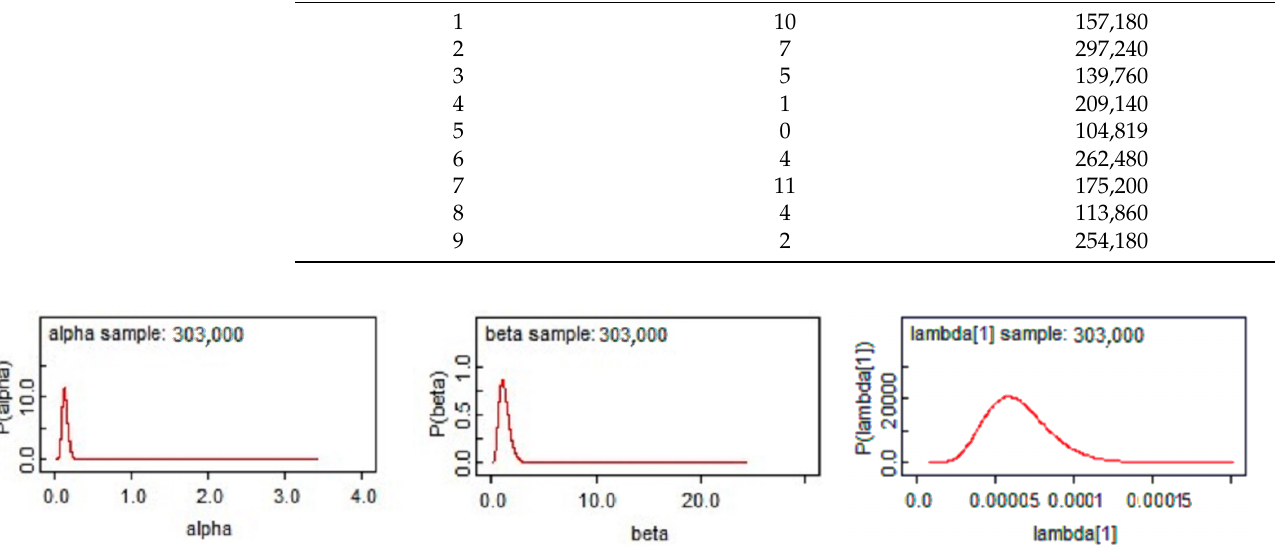
Figure 5. Density functions for α , β , and (cid:2245) .